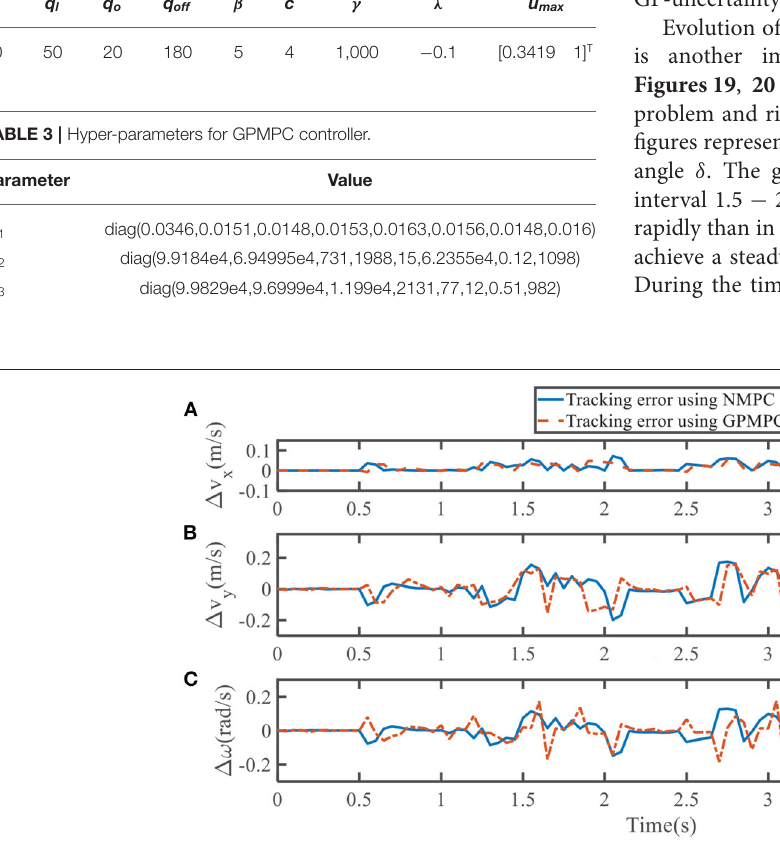
FIGURE 5 | Tracking error using NMPC and GPMPC in left overtaking. (A) Tracking error v x ; (B) Tracking error v y ; (C) Tracking error ω .